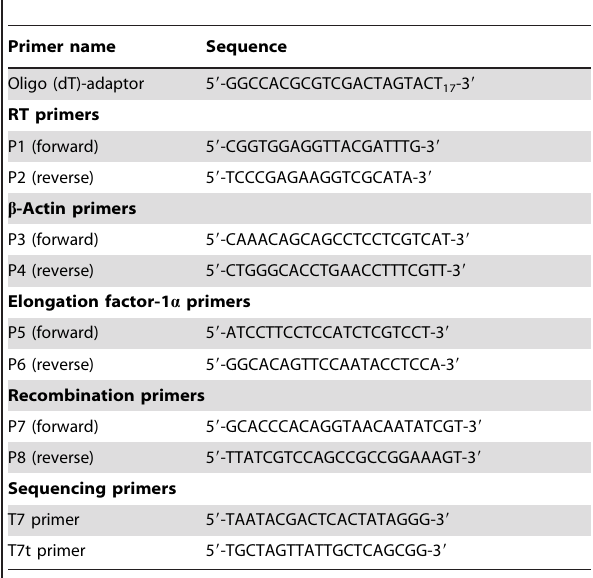
Table 1. Names and sequences of primers used in this